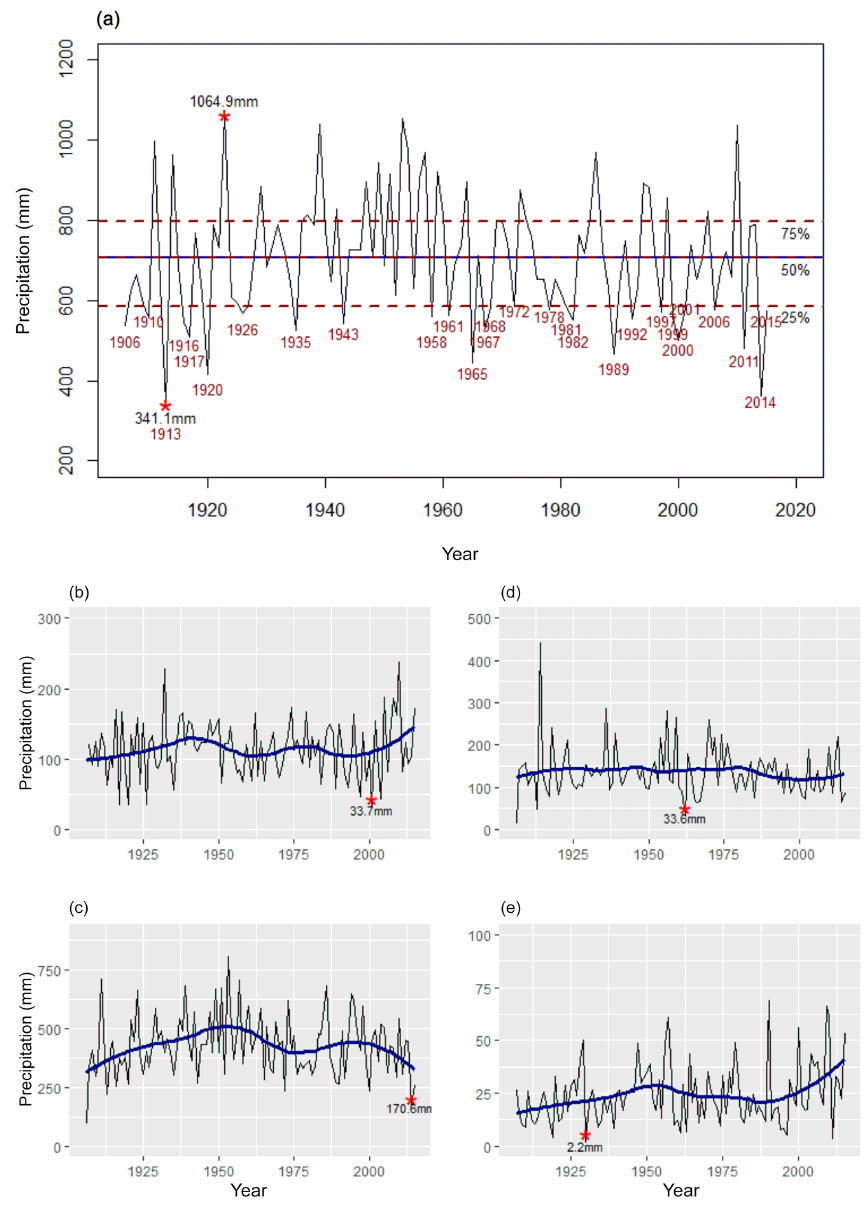
Figure 4. Annual and seasonal precipitation from 1906 to 2015: (a) annual (quartiles indicated by dashed lines), (b) spring, (c) summer, (d) autumn and (e) winter. A 30-year Savitzky–Golay filter is presented (bold line in b–e